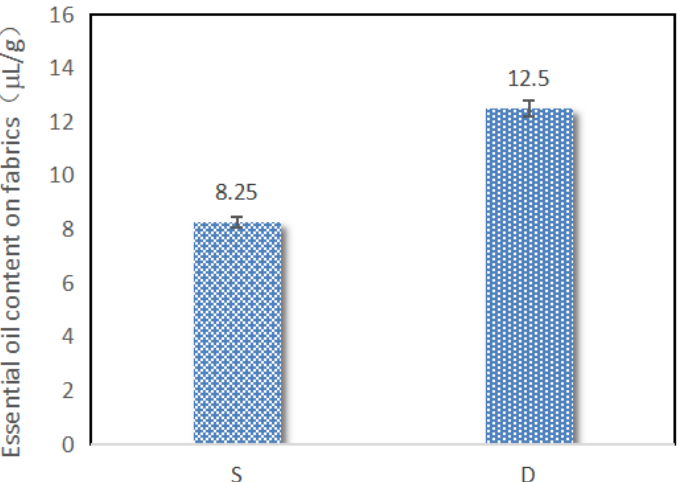
Figure 7. Essential oil contents of fabrics finishing with single-layered (S) and double-layered (D) microcapsules.